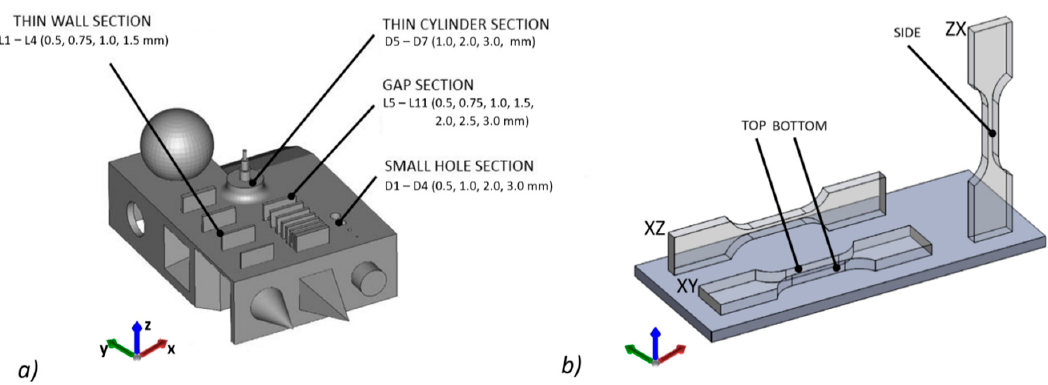
Figure 1. Specimen’s geometry: ( a ) benchmark model with build orientation and small features explained, ( b ) tensile specimen’s orientation in build direction and surfaces used to measure roughness.